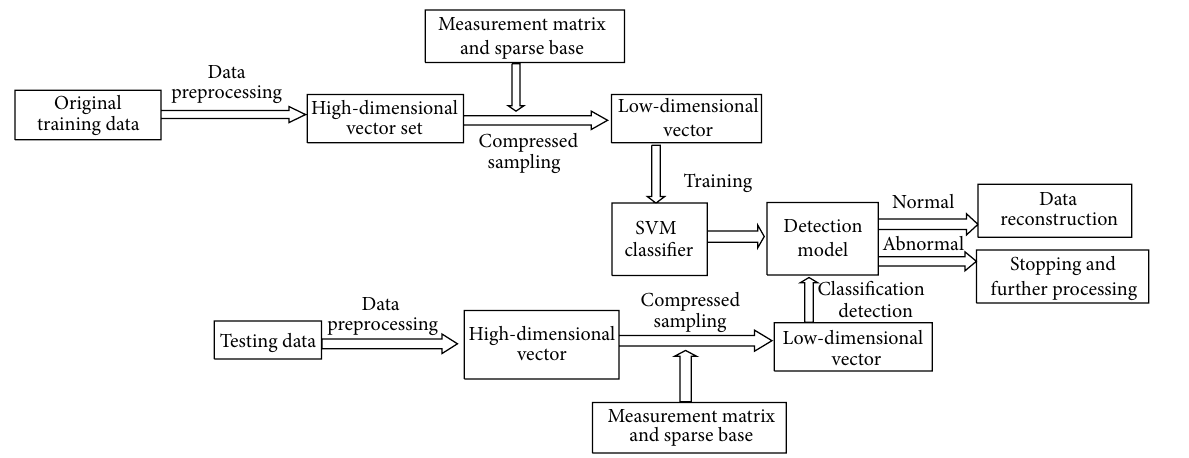
Figure 1: Intrusion detection process based on compressed